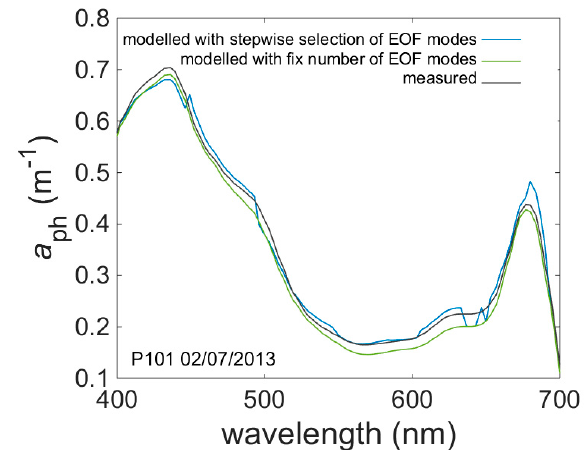
Figure 9. Comparison between phycobilin pigment (phycocyanin ( a ) and phycoerythrin ( b )) concentrations measured in situ and derived from the EOF model.